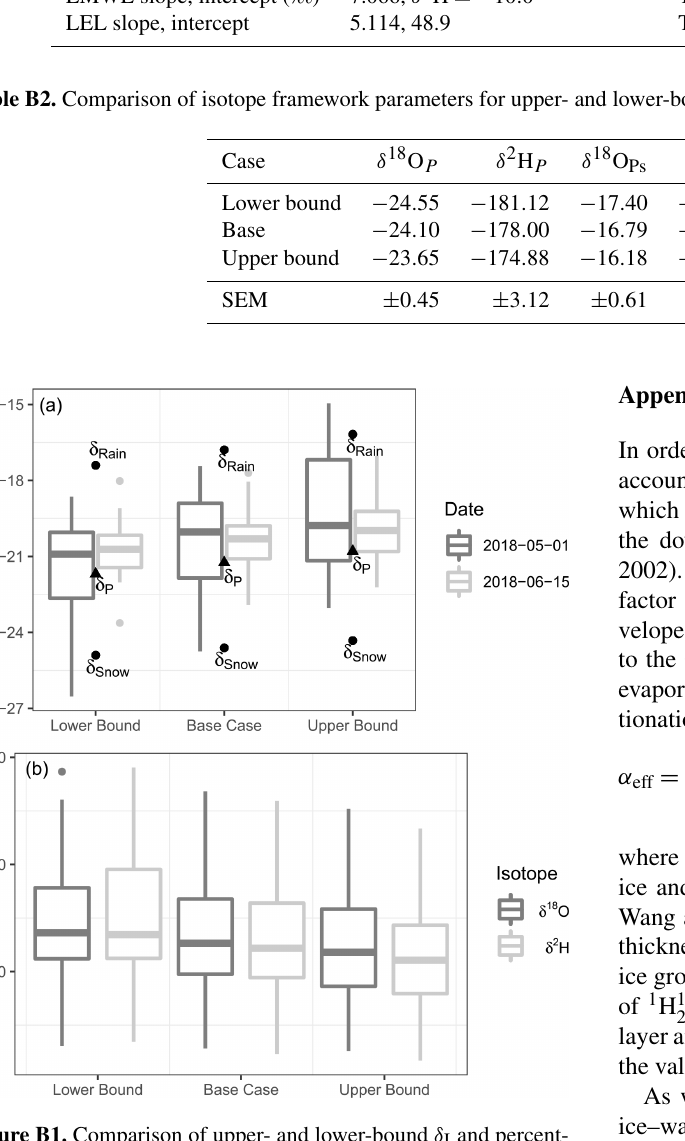
Figure B1. Comparison of upper- and lower-bound δ I and percent- age lake water replacement values against the base